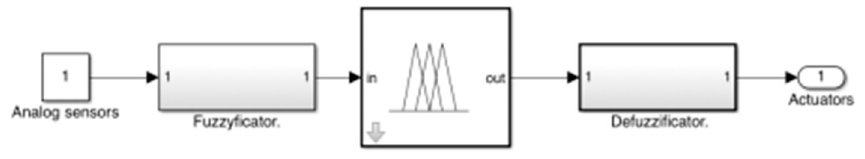
Figure A1. Fuzzy logic system diagram.